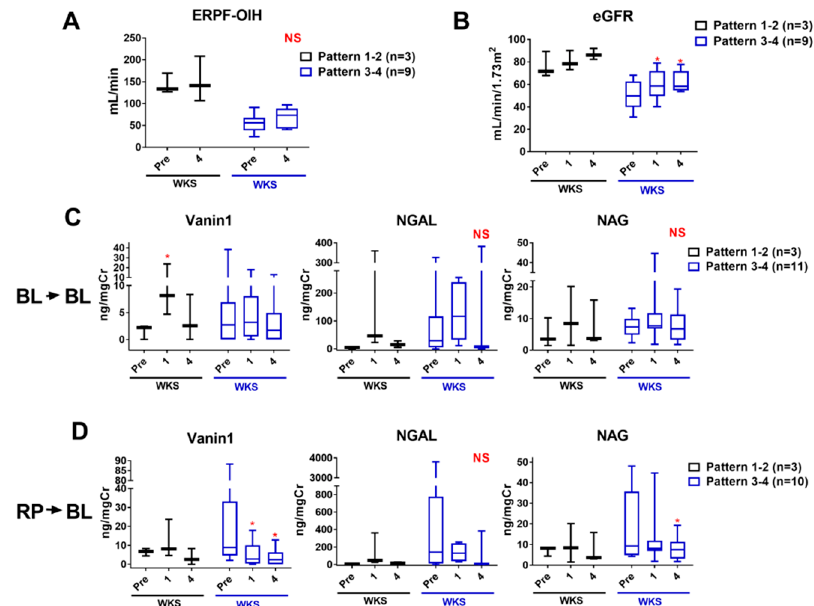
Figure 5. Changes in renal function and each AKI biomarker after intervention. ( A, B ) Changes in renal functions, as assessed by normalized ERPF-OIH ( A ) and eGFR ( B ), before and after intervention in pattern 1–2 (black) and pattern 3–4 UUTO (blue) cases are shown. ( C, D ) Changes in each AKI biomarker before and after intervention in pattern 1–2 (black) and pattern 3–4 UUTO (blue) cases are shown. The levels of each bladder ( C ) and renal pelvic biomarker ( D ) before intervention were compared to those of each bladder biomarker after intervention. Data were analyzed using two-way repeated measures ANOVA with Tukey’s multiple comparisons test. * p < 0.05 vs . pre (before intervention, pre); NS, not significant; wks, weeks; BL: bladder; RP renal pelvis.